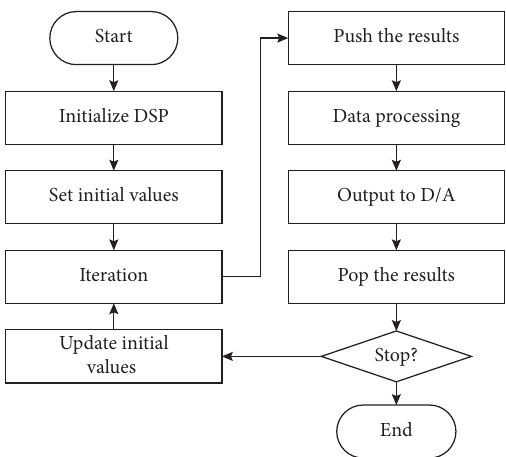
Figure 4: Flowchart for DSP implementation of the Chua system with hidden attractors.